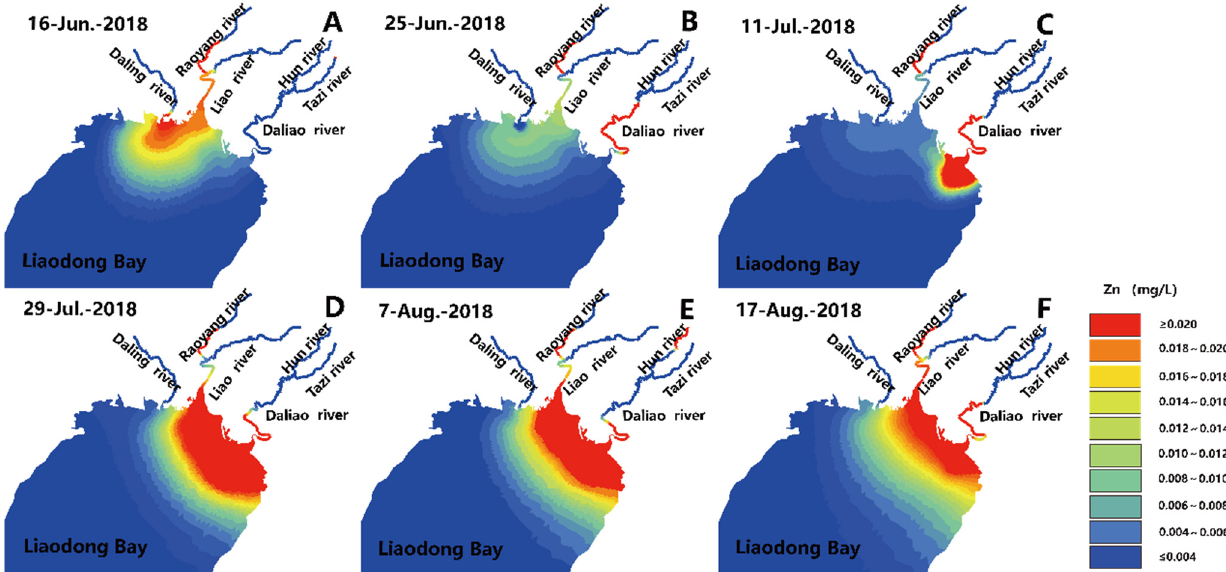
Figure 11. Sudden water pollution accident in the Taizi River pollutant transport spread.